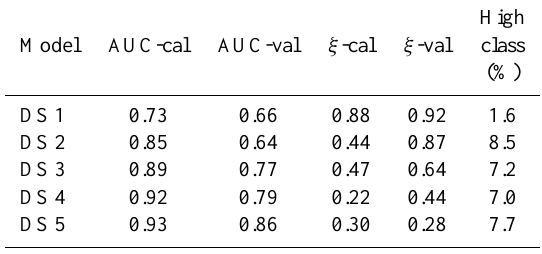
Table 4. Summary of the quality statistics calculated for each landslide susceptibility map (cal=calibration landslide data, val=validation landslide data). Model AUC-cal AUC-val